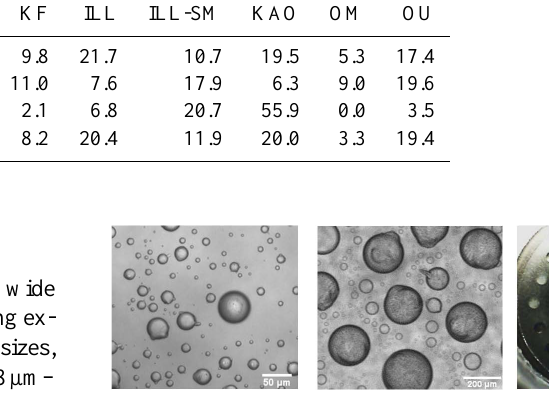
Fig. 3. Droplet sizes used to examine the ice-nucleating efficiencies of soil dusts. From left to right are images captured during the pico-, nano- and micro- drop freezing experiments (DFE)